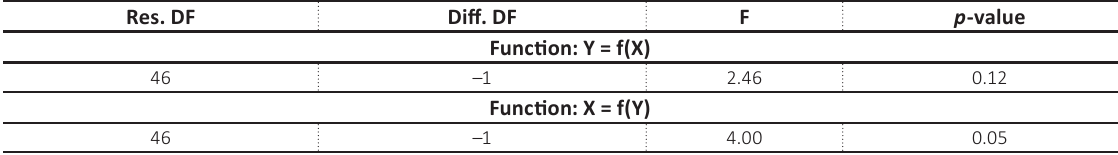
Table E4. Ranking in 50 largest economies (X) and non-government corporate ESG disclosure (Y) Res. DF